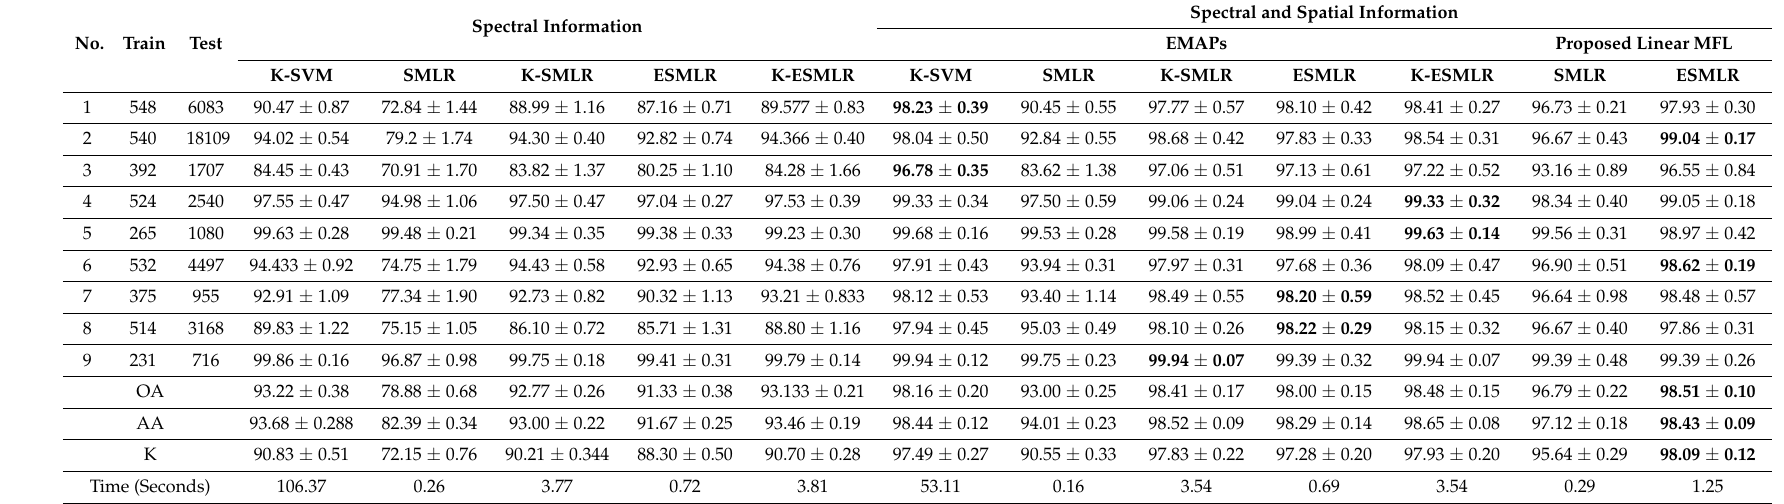
Table 2. Classification accuracy (%) with 9% labeled samples in Pavia University dataset (Best result of each row is marked in bold